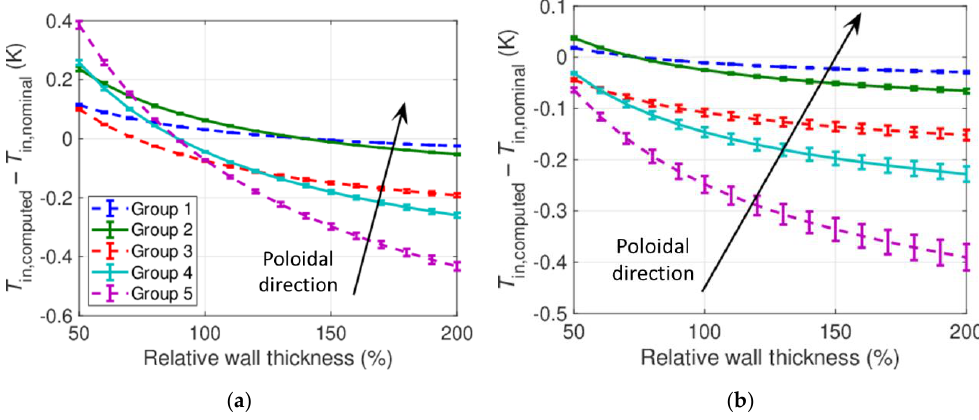
Figure 15. Distribution of the difference between the computed channel inlet temperature and its design value (295 °C), as a function of the wall thickness, for the case with radiation and adiabatic PbLi manifolds: ( a ) FW manifolds; ( b ) BZ manifolds. Different lines represent different groups of channels in the poloidal direction, according to the lumping strategy (see Section 2 above and the nomenclature in Figure 6). Negative numbers mean that the computed inlet temperature is smaller than its nominal value.